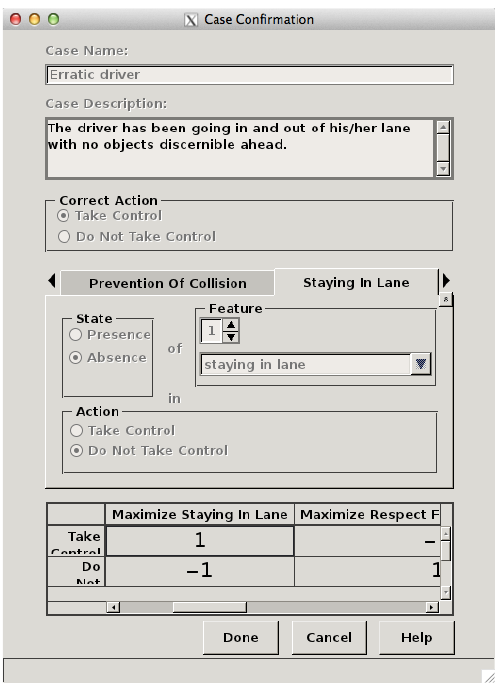
Figure 3 GenEth’s case confirmation dialogue which displays the duty satisfaction/violation values determined from case input.